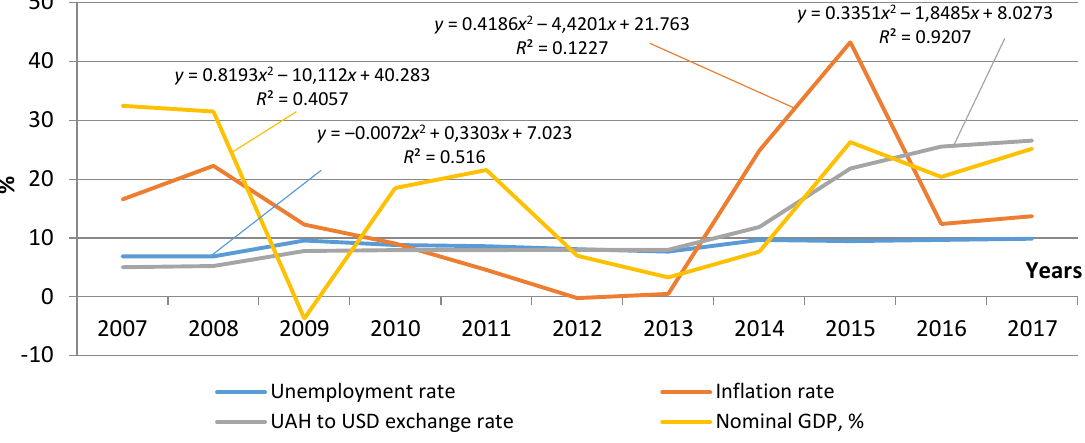
Figure 5. Influence of social system factors on GDP